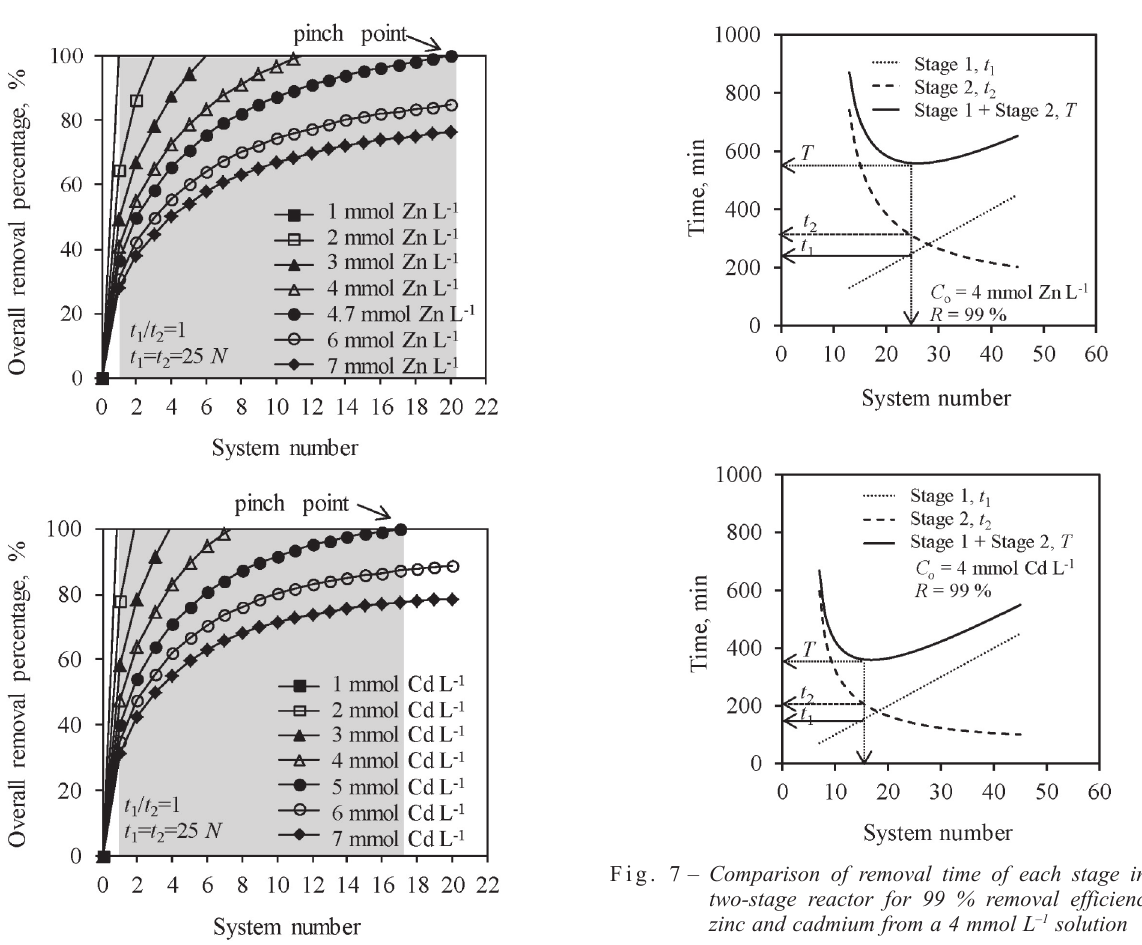
Fig. 6 – Effect of the chosen initial metal concentration on the overall removal percentage of zinc and cadmium ions on IMZ in the two-stage reactor